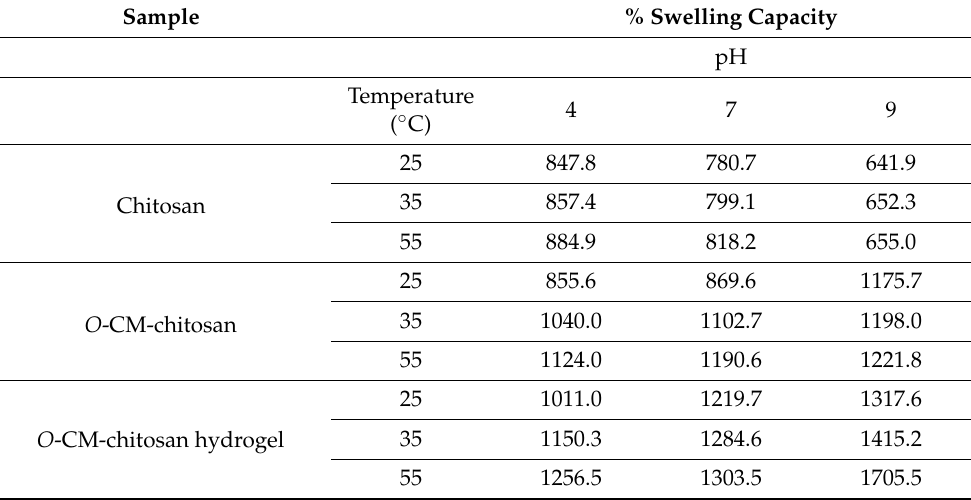
Table 1. Temperature and pH impact swelling capacity for chitosan, O -CM-chitosan, as well as O -CM-chitosan